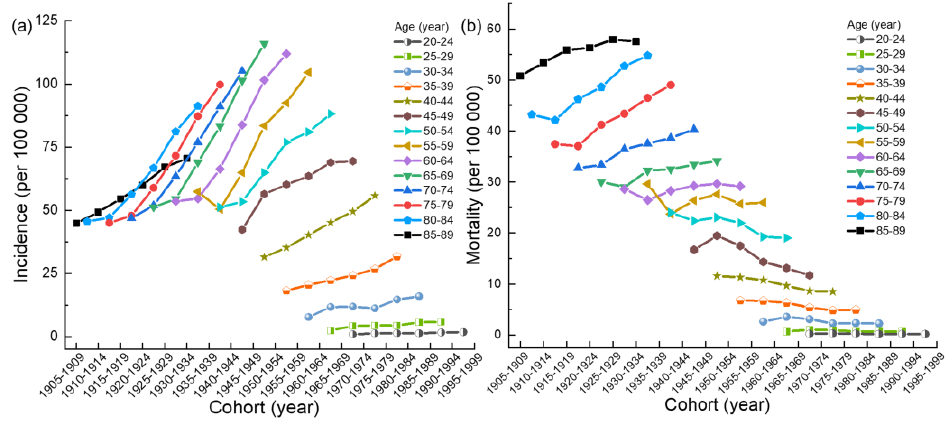
Figure 3. ( a ) Cohort trends of the incidence of breast cancer in Chinese women. ( b ) Cohort trends of the mortality of breast cancer in Chinese women.